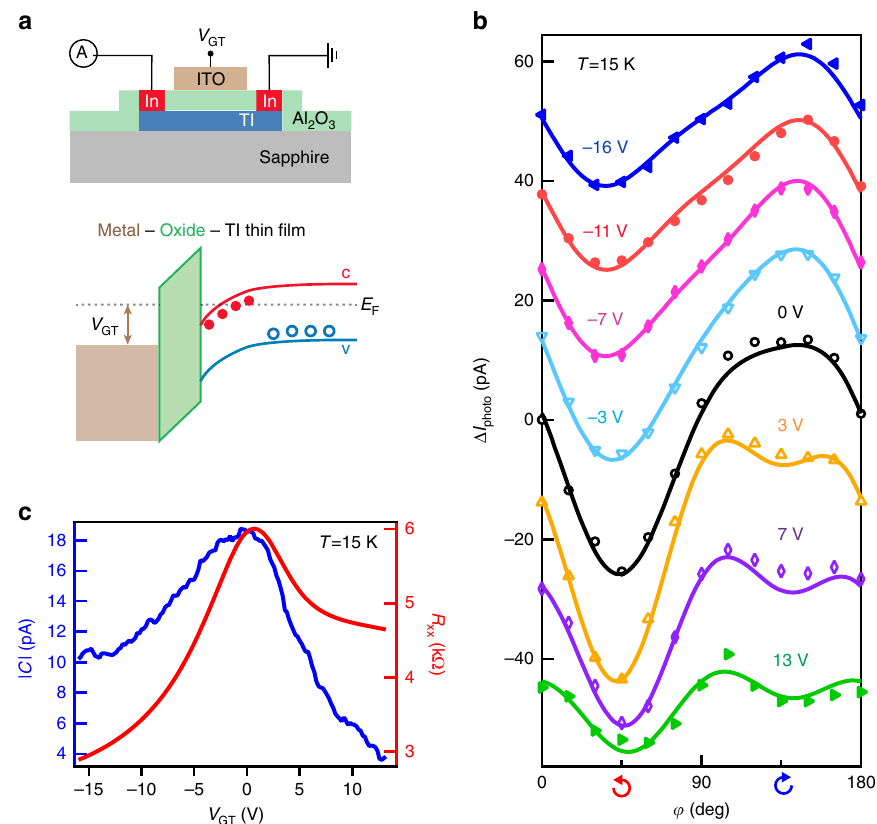
Fig. 2 Chemical potential dependence of photocurrent in top-gated device B. a Sketch of the metal-oxide-TI heterostructure for the top gate. The Al 2 O 3 is the dielectric layer and the ITO on top serves as a transparent contact for applying the top gate voltage V GT . The bottom fi gure shows the band bending and associated chemical potential moving when a positive V GT is added. b The polarization-dependent photocurrent at different V GT is measured at 15 K in device B. The photocurrents are offset for a better display. We fi t the polarization-dependent photocurrent at each V GT to Eq. (1), denoted by the solid line . c Four-probe measurement of the longitudinal resistance R xx as a function of the gate voltage, denoted by the red curve . Around zero gate voltage, R xx reaches a maximum, indicating the chemical potential approaches the Dirac point. The absolute value | C | of the amplitude of the HDPC is denoted by the blue curve . | C | also reaches a peak around zero gate